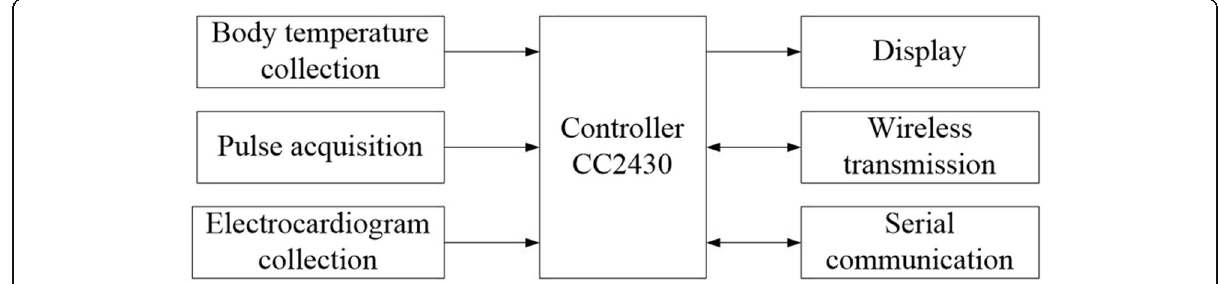
Fig. 7 System software block